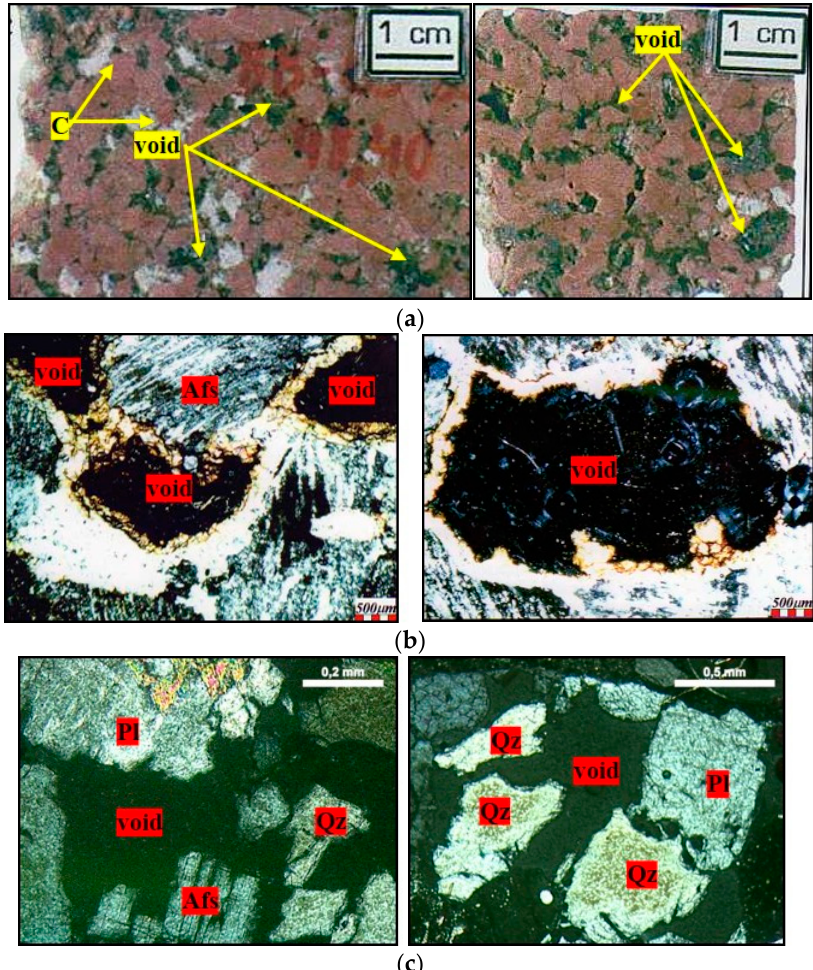
Figure 16. Quartz dissolution by alkaline fluids, where Afs = K-feldspar, Pl = plagioclase, C = carbonate, and Qz = quartz. ( a ) Photographs of the epissienite rock [36]; ( b ) micrographs obtained by optical microscopy under crossed-polarized of the epissienite [36]; ( c ) micrographs obtained by optical microscopy under crossed-polarized of rock fragments after the accelerated mortar bar test, 5× magnification and 10× magnification.